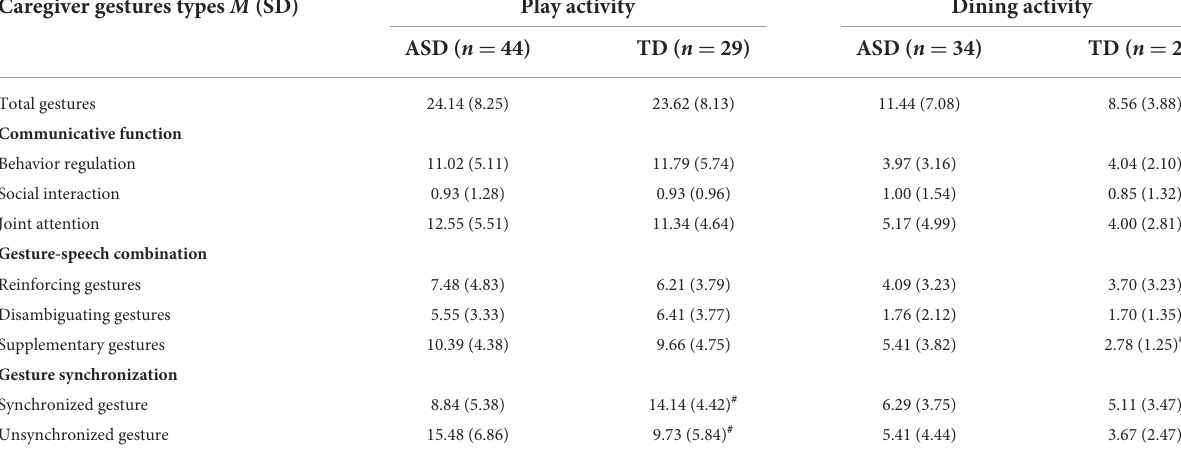
TABLE 3 Gesture frequency of caregivers caring for toddlers with autism spectrum disorder (ASD) and typically developing (TD) toddlers during different activities. Caregiver gestures types M (SD) Play